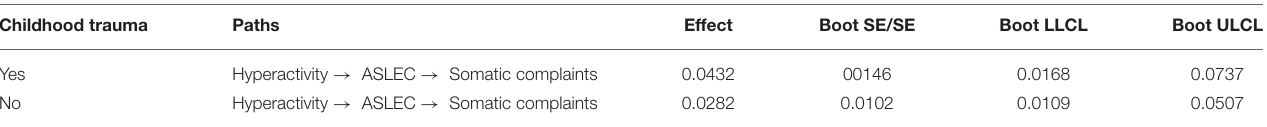
TABLE 5 | Test of the indirect path for the relationship between hyperactivity and somatic complaints in exposed and non-exposed childhood trauma populations in moderation mediation analysis.